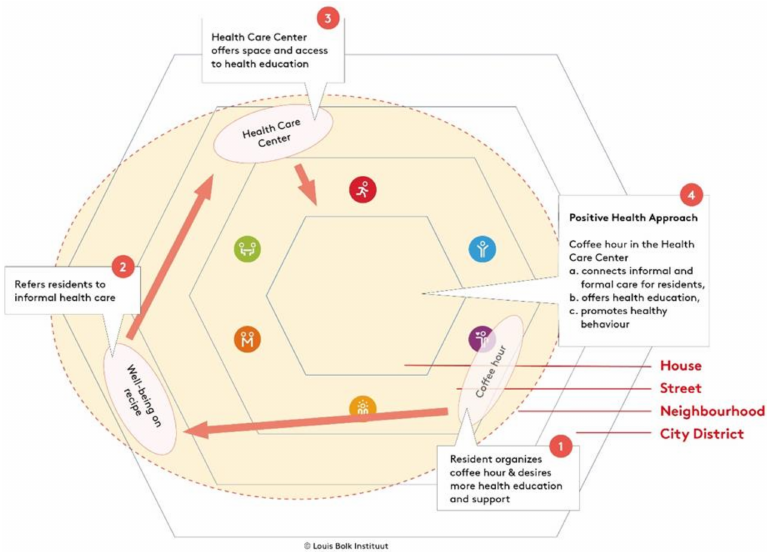
Figure 5. Implementation of a health promotion pilot. Note: An example illustration of how the Bolk model guided implementation of the HPP: coffee hour in the health care center. The four-step process is described in more detail under Section